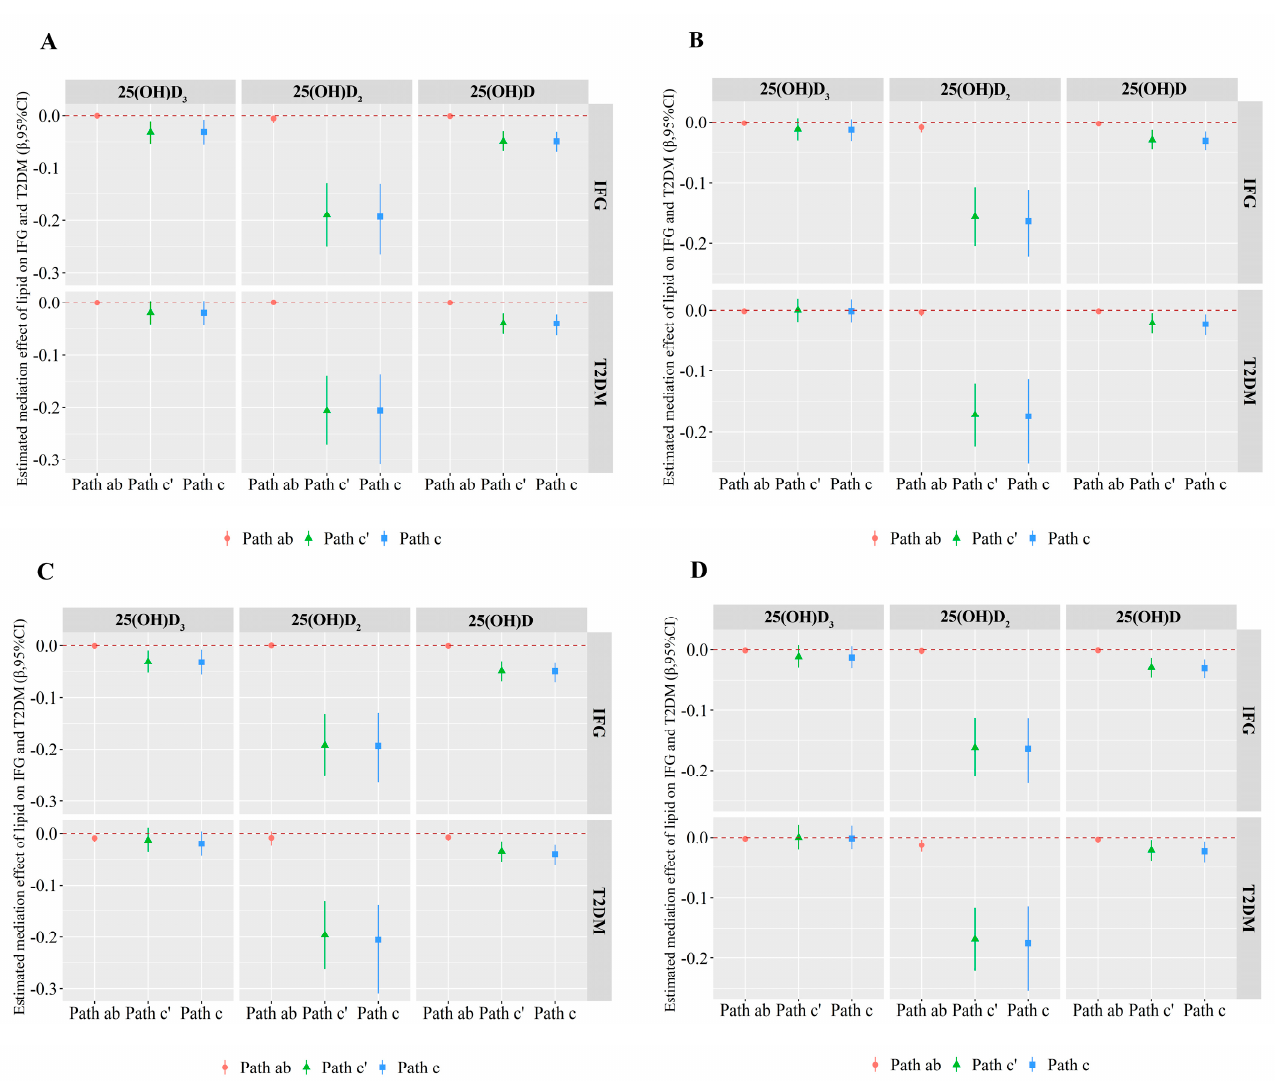
Figure 2. Mediation analysis of the relationships between 25(OH)D 3 , 25(OH)D 2 or 25(OH)D and IFG or T2DM by lipid levels in males and females, respectively. Path ab, Path c’ and Path c represent the indirect, direct and total effects of vitamin D on diabetes status with lipid levels (PC I and PC II) as a mediator in males and females, respectively. ( A ) displays the mediation effect of PC I on the association between 25(OH)D 3 , 25(OH)D 2 or 25(OH)D and IFG or T2DM in males; ( B ) displays the mediation effect of PC I on the association between 25(OH)D 3 , 25(OH)D 2 or 25(OH)D and IFG or T2DM in females; ( C ) displays the mediation effect of PC II on the association between 25(OH)D 3 , 25(OH)D 2 or 25(OH)D and IFG or T2DM in males; ( D ) displays the mediation effect of PC II on the association between 25(OH)D 3 , 25(OH)D 2 or 25(OH)D and IFG or T2DM in females. Adjusted for alcohol intake, smoking status, physical activity, average monthly individual income, level of education, BMI, SBP, PP, and a family history of T2DM. Abbreviations: IFG, impaired fasting glucose; T2DM, type 2 diabetes mellitus; 95% CI : 95% confidence interval.